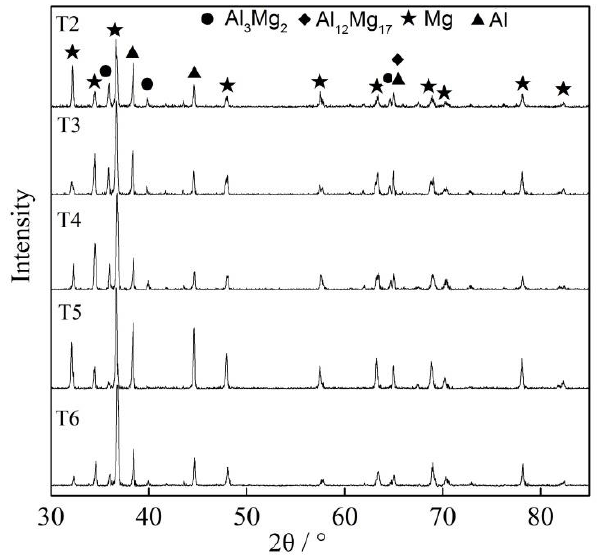
Figure 4. XRD patterns of the weld zone with different tool offset.